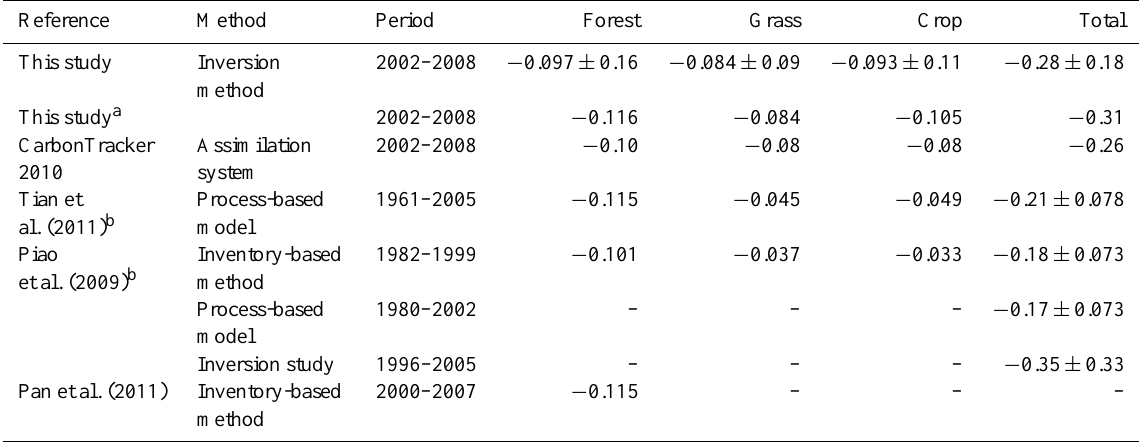
Table 3. Comparison of the terrestrial carbon sinks in China derived using different methods (PgCyr − 1 ).